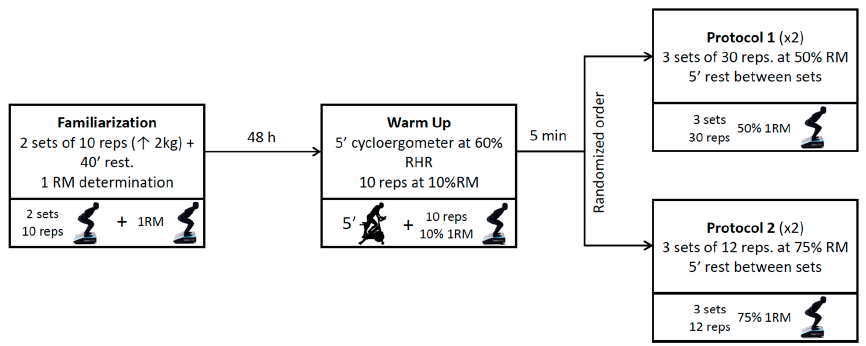
Figure 2. Protocol measurement of the squat exercise.